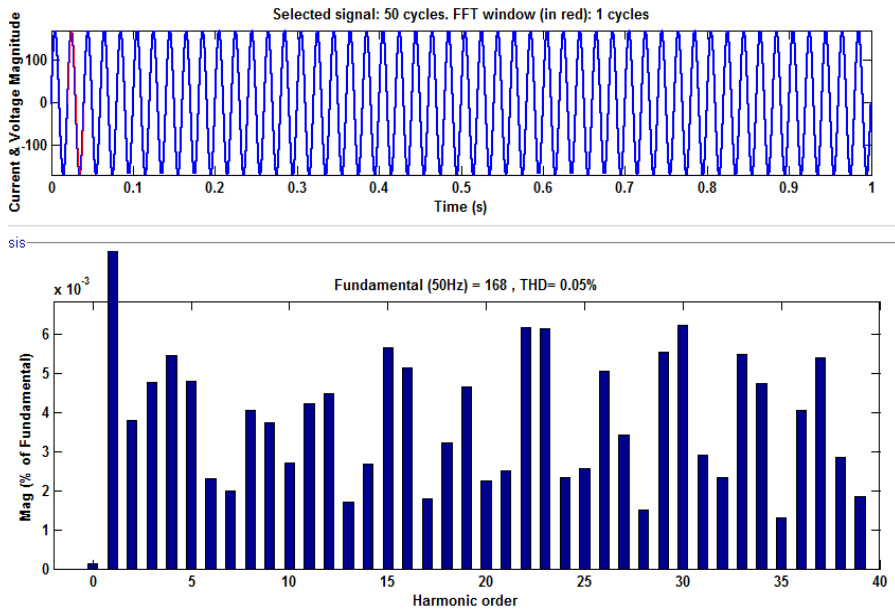
Figure 14. Load-side THD analysis.